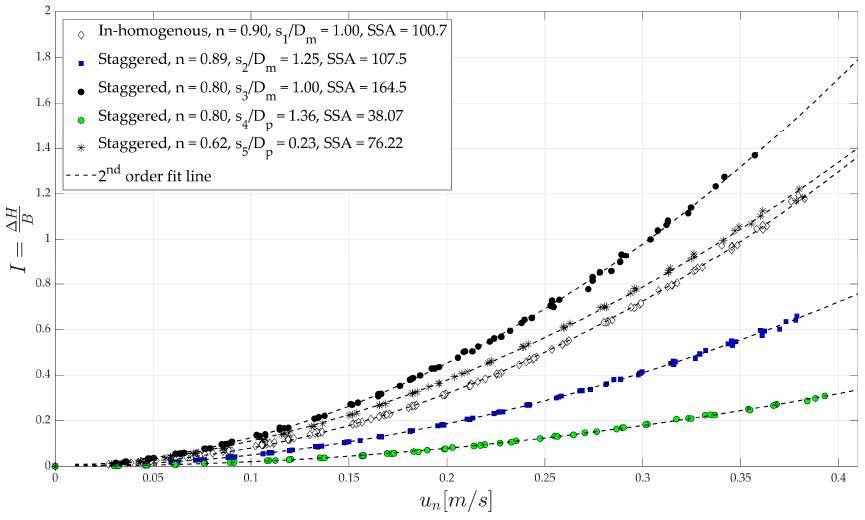
Figure 6. Pressure gradient ( I ) plots against pore velocity ( u n ) of all cases.